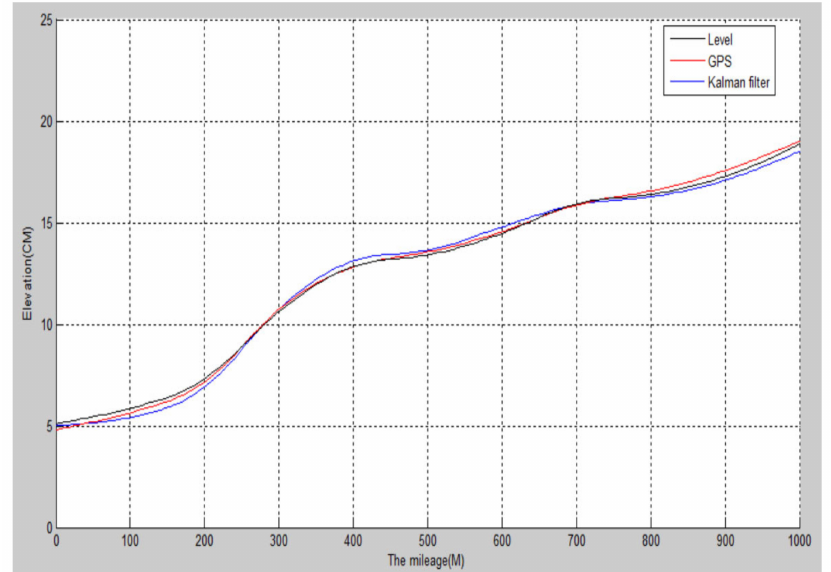
Figure 8. Kalman filter elevation contrast.